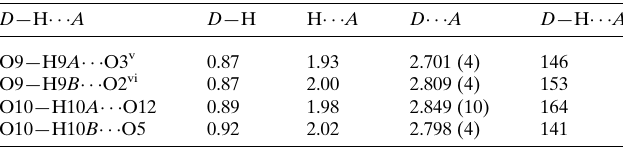
Table 2 Hydrogen-bond geometry (A˚ , (cid:5) ).